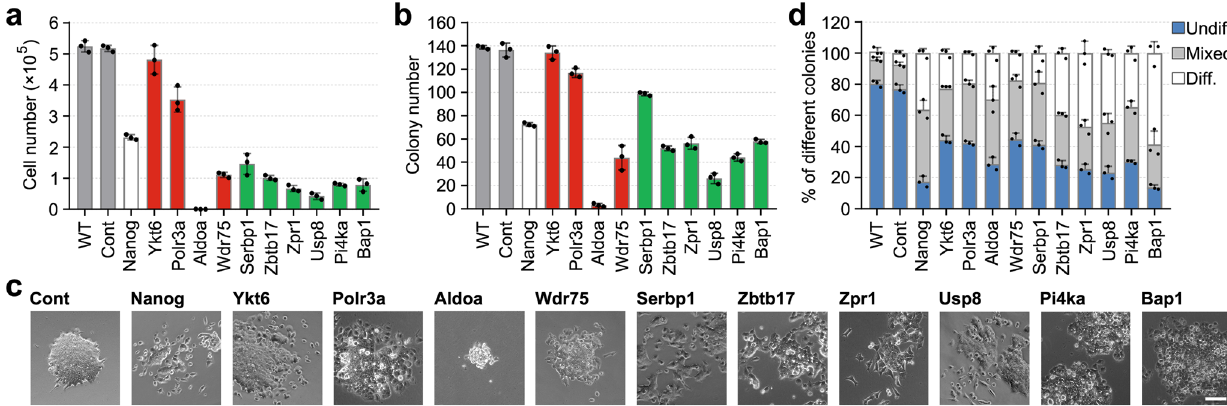
Fig. 3 Phenotypic validation of the candidate gene. a The proliferation rates of WT, Cont (cells infected with control sgRNA) and target gene knockout cells. The indicated cells (1000 cells per cm 2 in 12-well plates) were cultured in L/S for four days, and the cell numbers were counted. b Colony numbers of the indicated cells. Cells were seeded into 12-well plates at a density of 200 cells per well and grown for 6 days, and colony numbers were counted. c Morphology of colonies formed by the indicated cells. Scale bar, 200 μ m. d Colonies were fi xed and stained for AP and then scored as undifferentiated, mixed, or differentiated. Data in ( a , b and d ) are represented as the mean ± SD; n